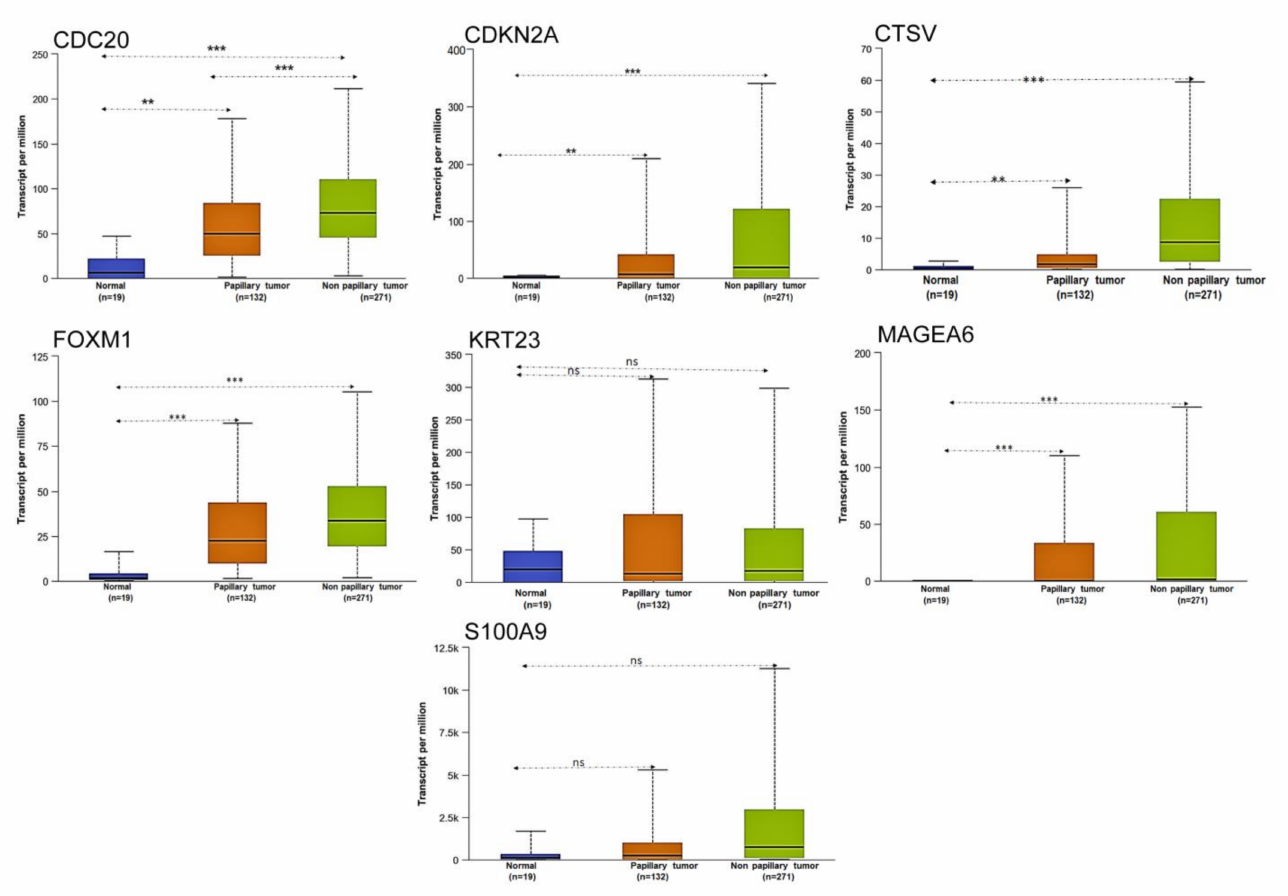
Figure 7. Expression of seven gene subset in bladder cancer based on histologic sample types. The expression of CDC20, CDKN2A, CTSV, FOXM1, KRT23, MAGEA6 and S100A9 based on tumor subtype. The figures are generated using ULCAN database. ** p < 0.001 and *** p < 0.0001 were considered statistically significant. ns,